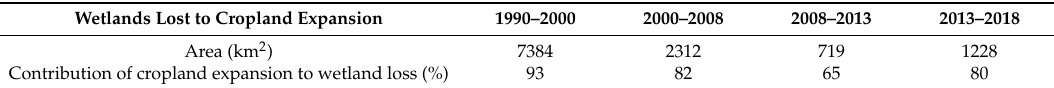
Table 2. Losses of wetlands to croplands in the SJP during di ff erent time periods. Wetlands Lost to Cropland